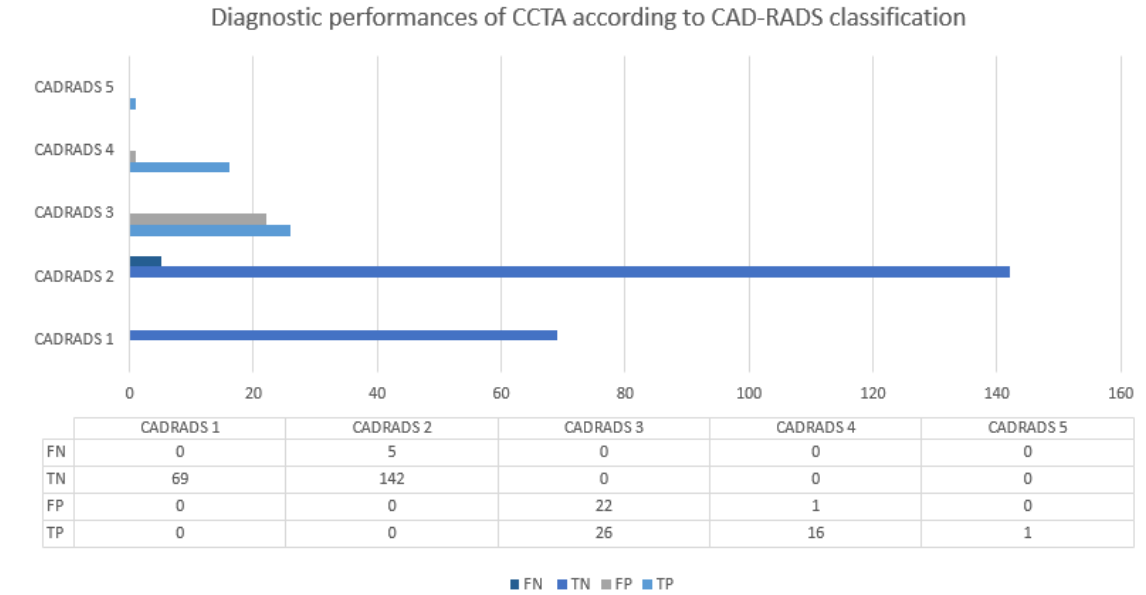
Figure 4. Results of CCTA and ICA according to the CAD-RADS category. At an artery-level evaluation, the LAD had the most misclassi fi ed lesions on the CCTA. False positive lesions were classi fi ed as CAD-RADS 3 in 96.22%, and false negative lesions were mainly classi fi ed as CAD-RADS 2